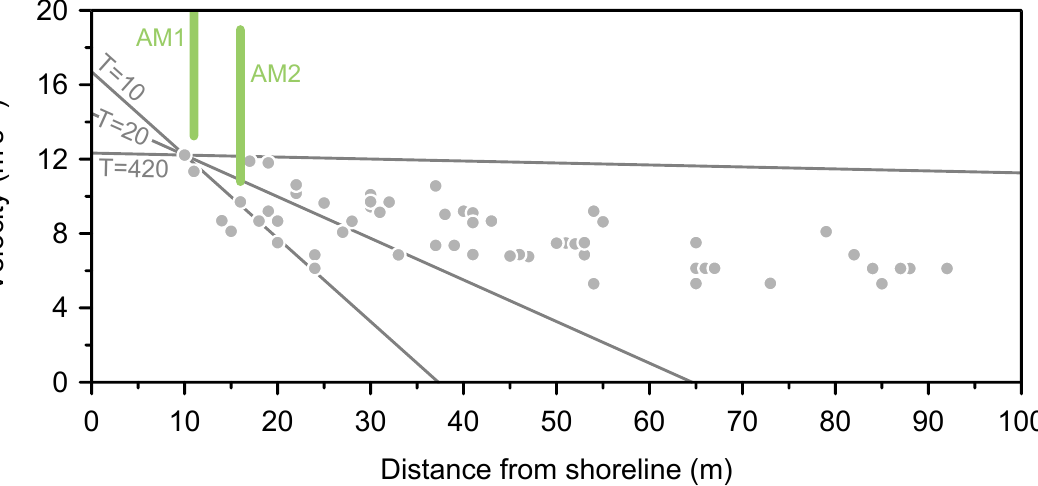
Figure 18. Minimum velocities required to pivot over the Lower Globigerina scarp (Equations (4a) and (4b)) for the two inverted boulders AM1 and AM2 (after [39]). The boulders are positioned at the scarp face where the movement took place. The velocities are set against the three hypothetical wave velocity decay profiles and the minimum velocities required for lifting / saltation of the remaining boulders of interest (greyed out). Vertical lines di ff erentiate between flow-parallel orientation of boulders (bottom of line) and flow-normal orientation (top of line). Note that boulder AM1 has an undefined upper velocity as the flow-normal case is unfeasible according to the